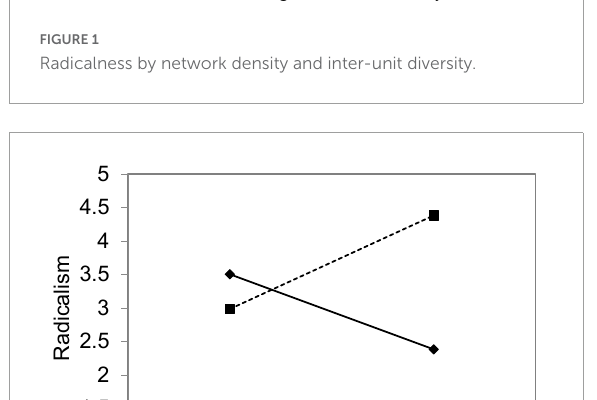
FIGURE1 Radicalness by network density and inter-unit diversity.